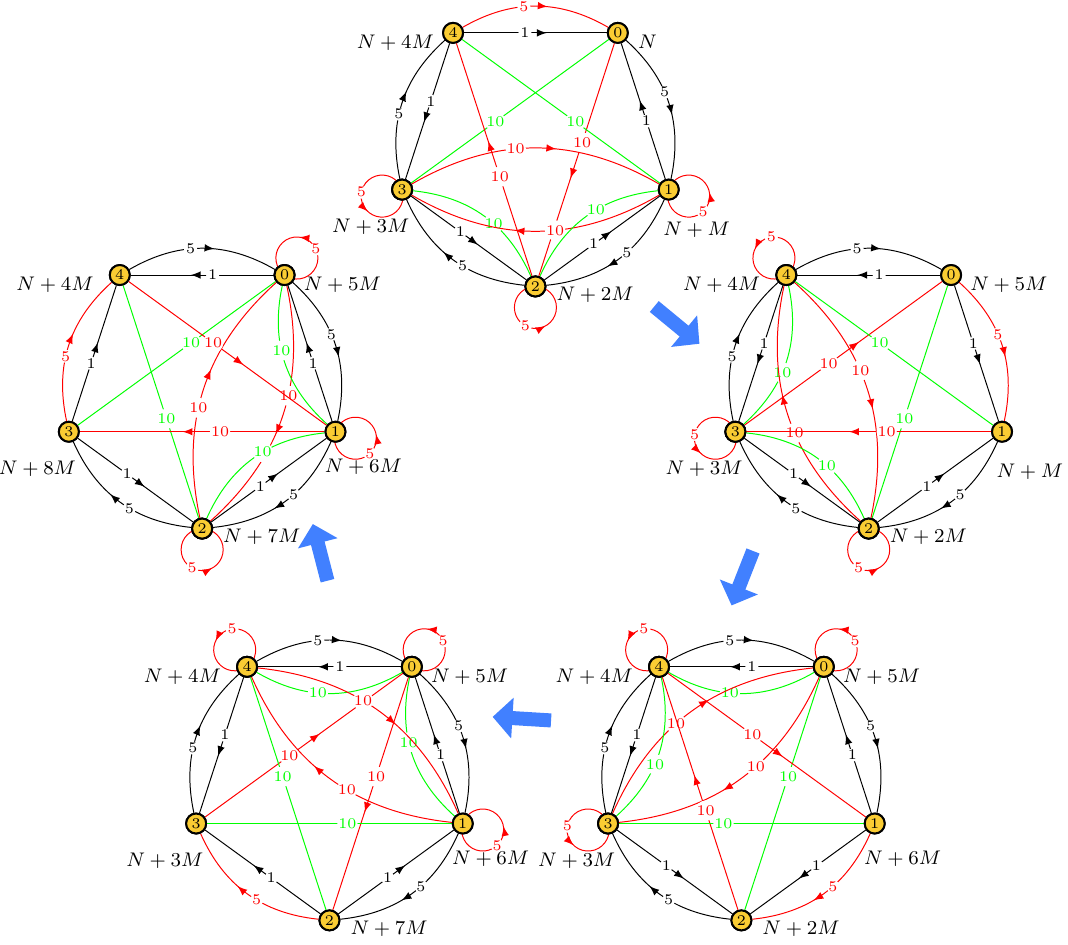
Figure 9. A period in the duality cascade for Y 1 ; 0 ( P 4 ), starting with N regular and M fractional branes. After each dualization, M remains (cid:12)xed and N